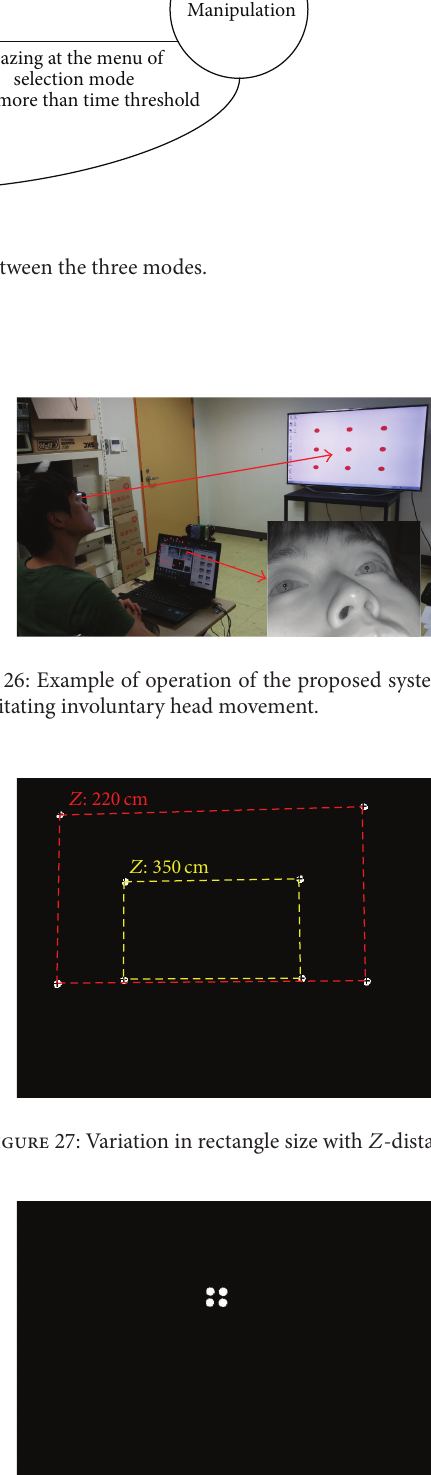
Figure 28: Frontal image of air conditioner switch at a 𝑍 -distance of 375